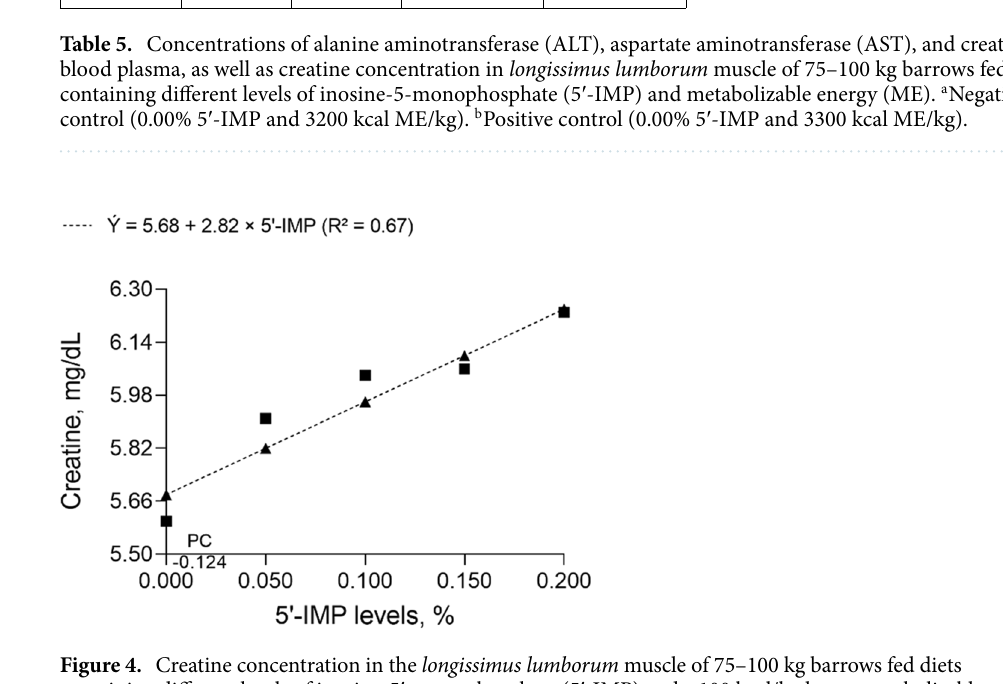
Figure 4. Creatine concentration in the longissimus lumborum muscle of 75–100 kg barrows fed diets containing different levels of inosine-5 ′ -monophosphate (5 ′ -IMP) and a 100 kcal/kg lower metabolizable energy level than the positive control (high-energy)